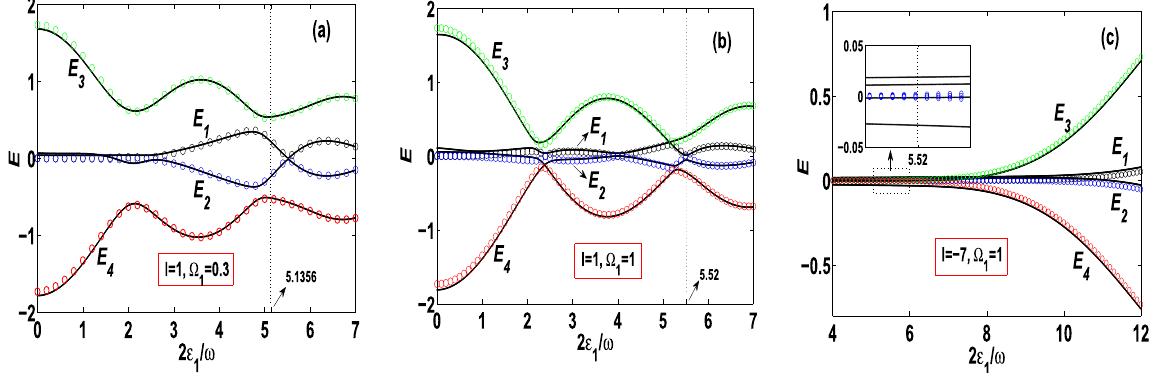
Figure 2. Quasienergies as functions of the driving parameter, E j = E j (2 ε 1 / ω ) for ω = 20, Ω 0 = 1, m = n = 1 and ( a ) l = 1,